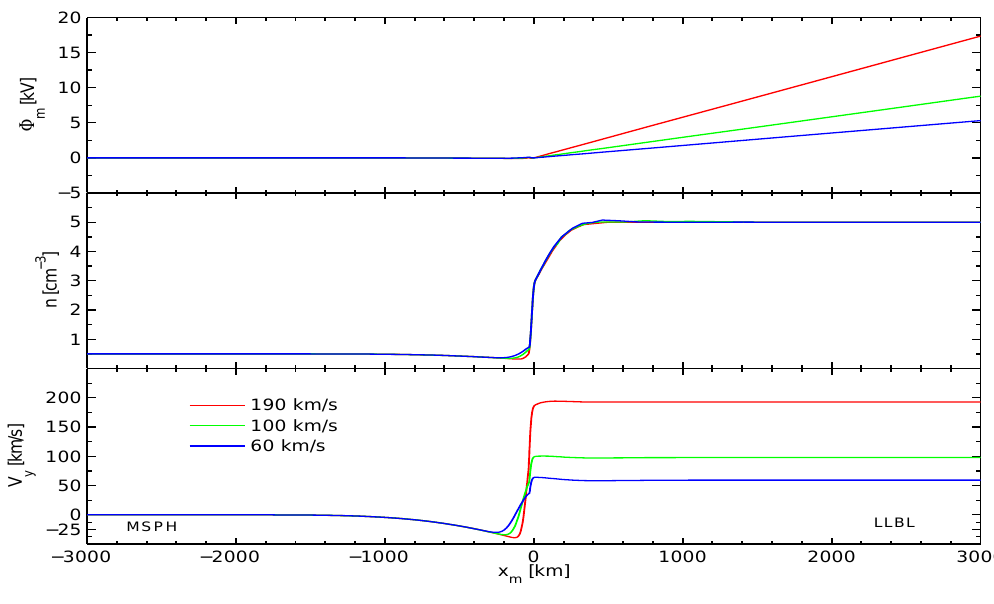
Fig. 2. Kinetic tangential discontinuity (TD) solution for the transition between magnetospheric (plasma sheet) plasma at rest (left hand side) and LLBL plasma moving in the y-direction (right hand side). The colors correspond to three different values of the plasma bulk speed V = V y ( V x = V z =0 everywhere). The planar TD is centered at x = 0, parallel to the yz plane. The panels show the variation with the x-coordinate (normal to the TD surface) of the magnetospheric electrostatic potential, 8 m , number density, n and the plasma bulk velocity V